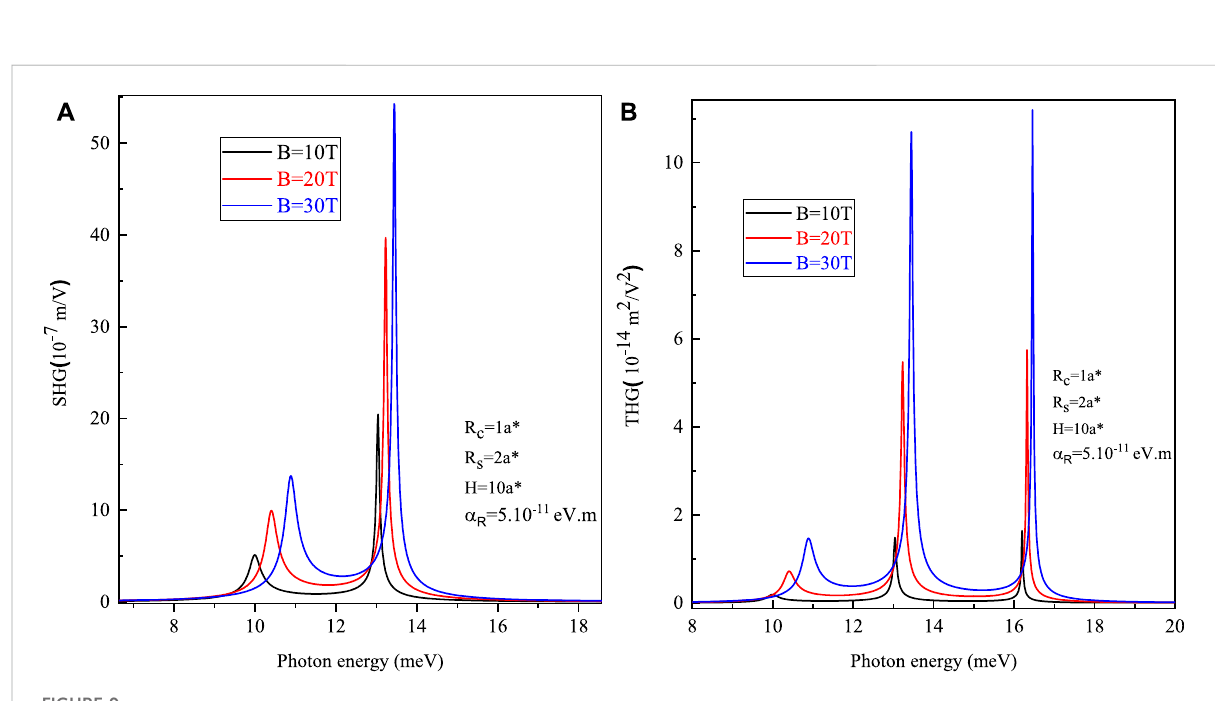
FIGURE 9 Second (A) and third (B) harmonic generation as functions of incident photon energy with differentvaluesof magnetic fi eld B = 10, 20, and 30 T and SOI strengths α R = 5 × 10 − 11 eV m , R c = 1 a *, R s = 2 a *, H = 10 a